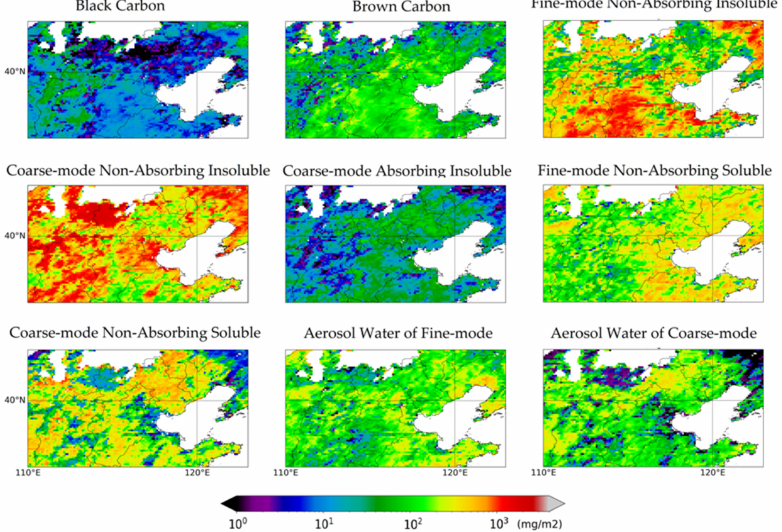
Figure 6. Monthly mean aerosol components mass concentrations (mg/m 2 ) in January 2012 retrieved from POLDER-3/PARASOL satellite observations.